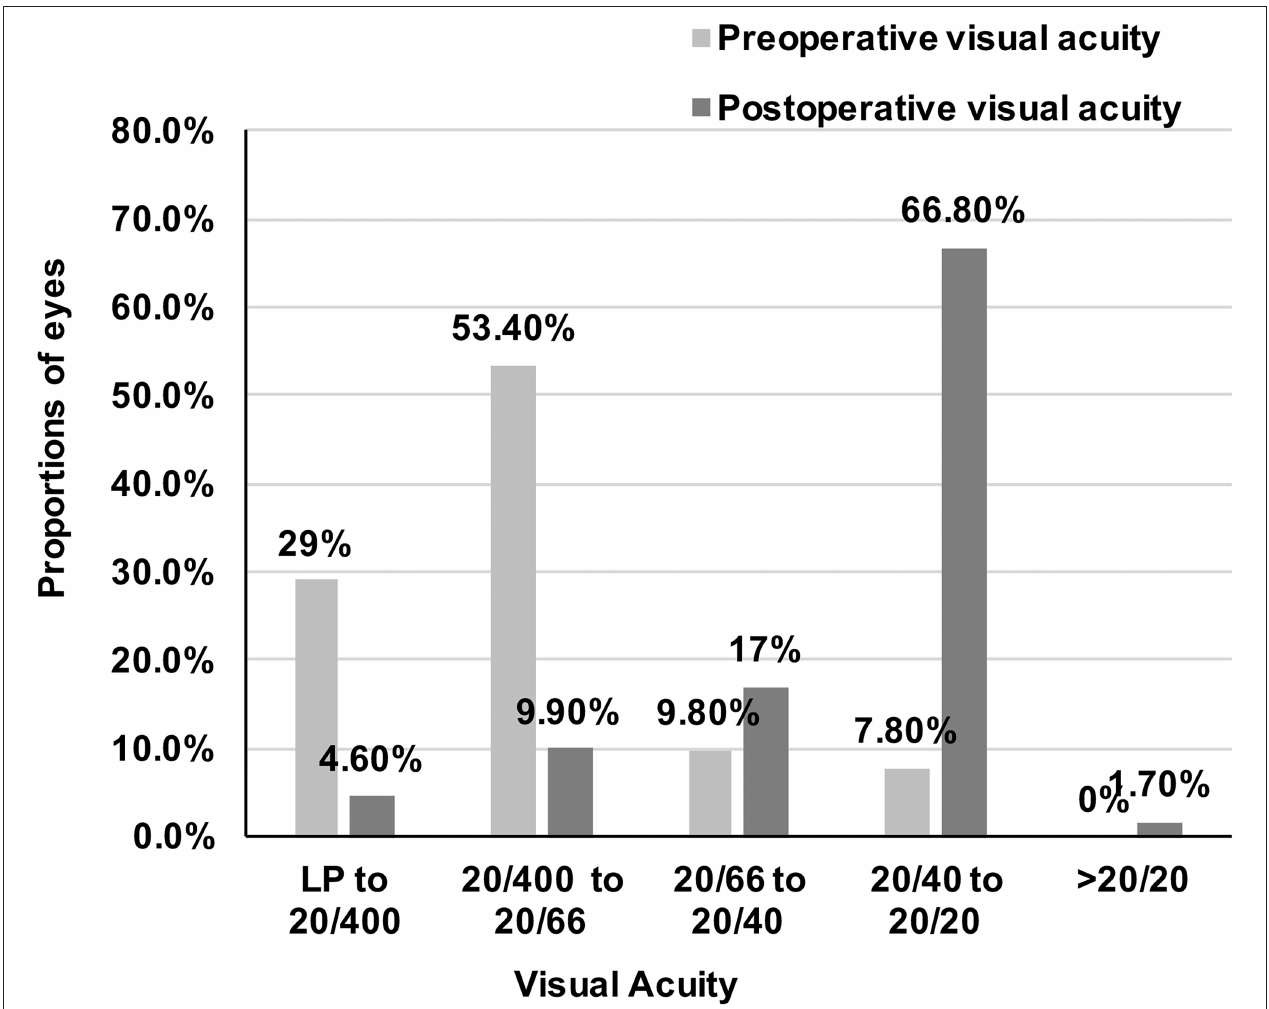
FIGURE 1 | Proportions of eyes with different visual acuity before and after surgery. Visual acuity of all patients significantly improved and most patients got visual acuity between 20/40 and 20/20 (1,354/2,027 eyes, 66.8%) after cataract surgery. LP, Light perception.